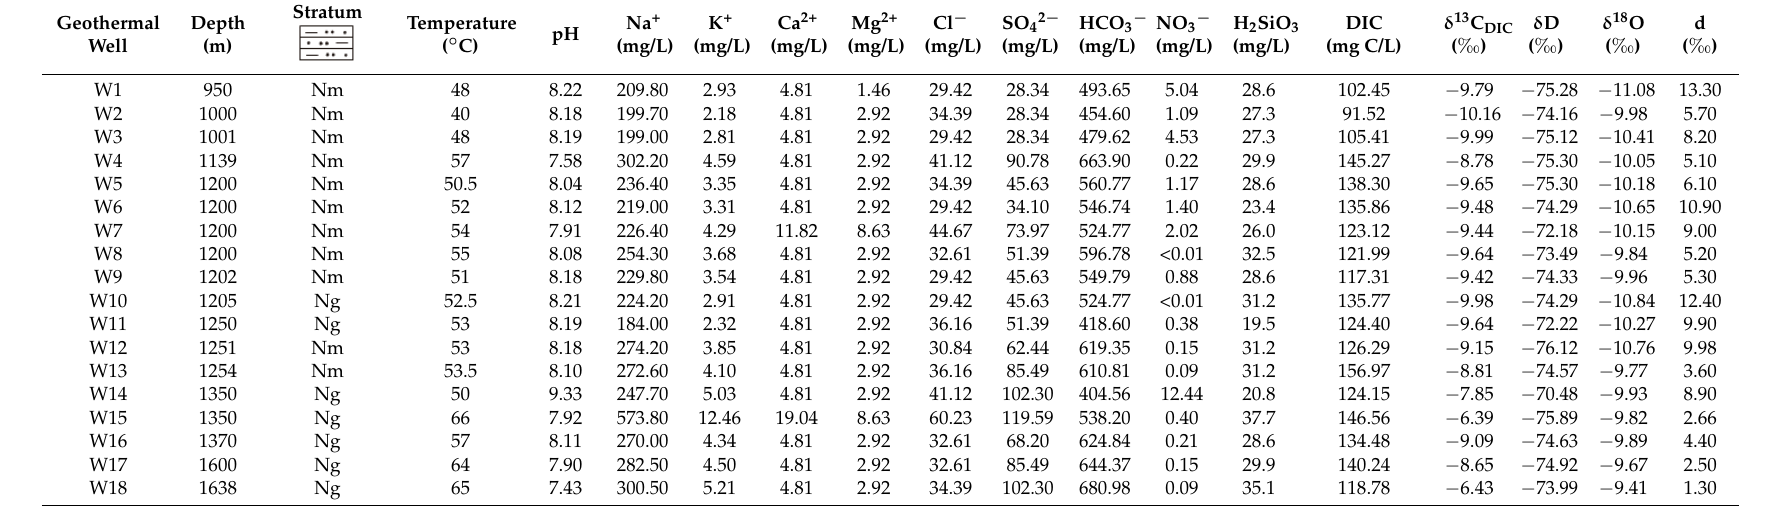
Table 1. Chemical composition and stable isotopic composition of geothermal water in Kaifeng city.